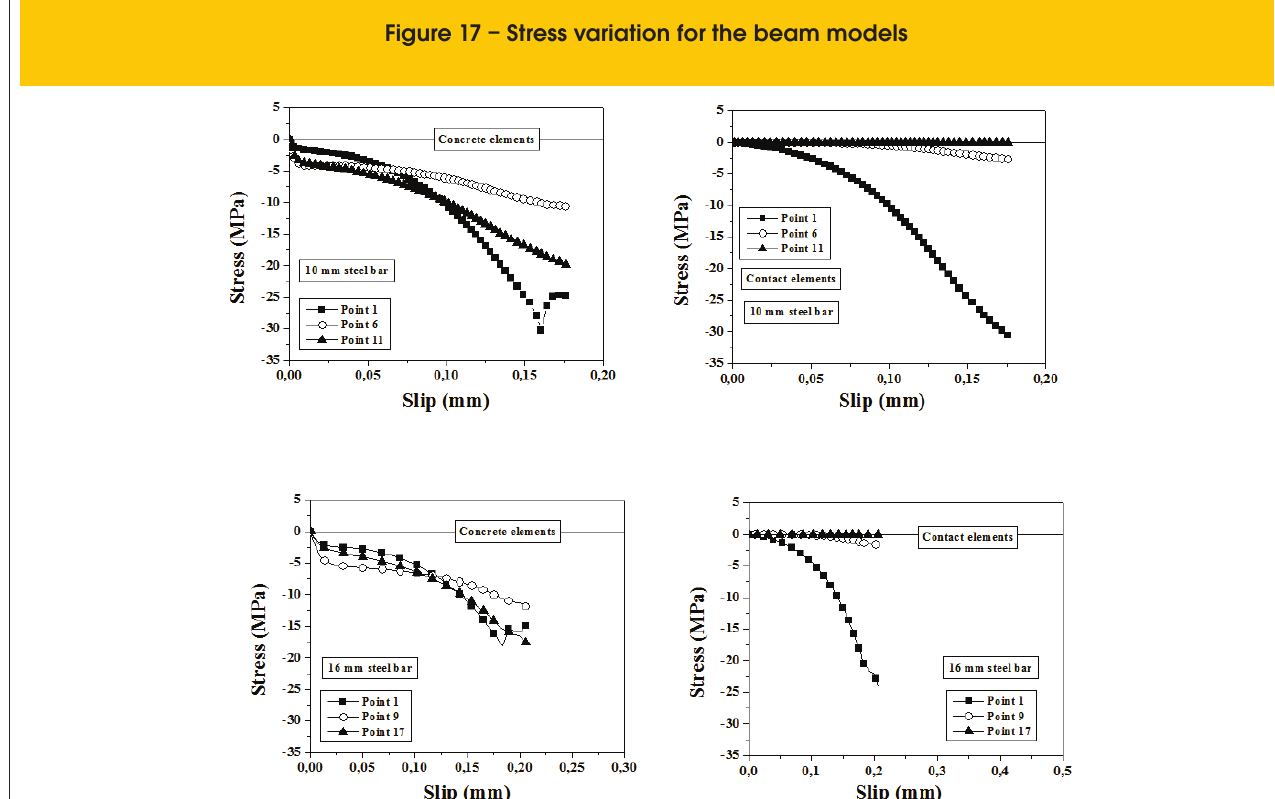
Figure 17 – Stress variation for the beam